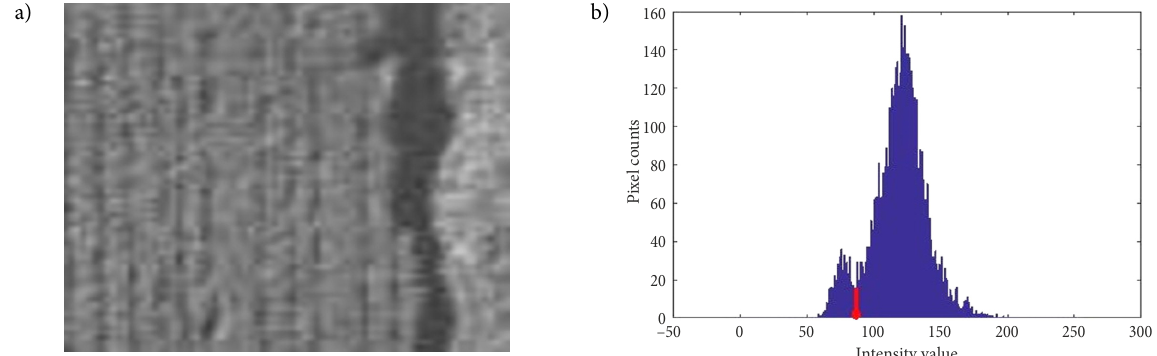
Figure 3. Histogram of a typical crack block: a – crack block; b –